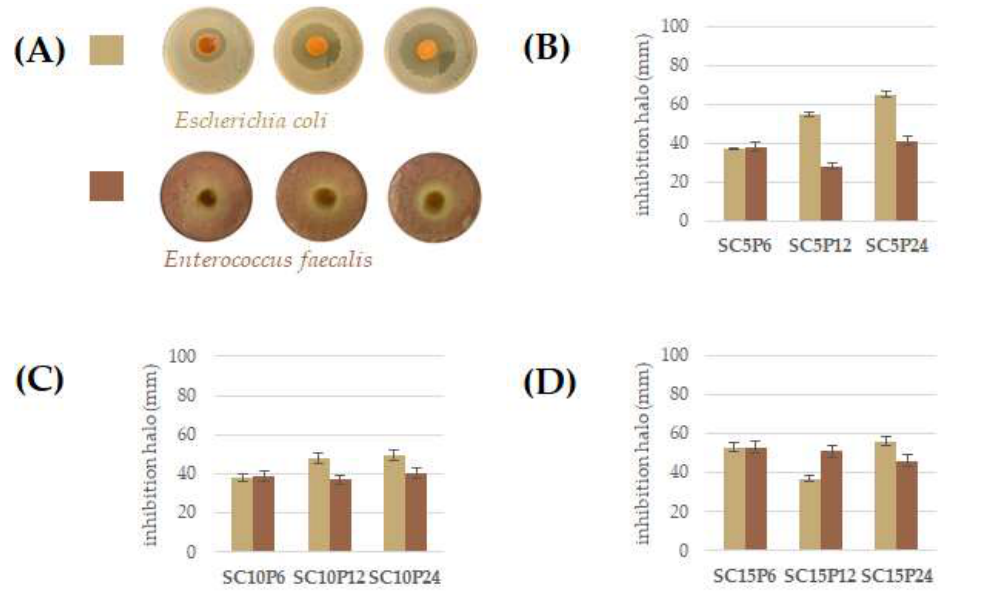
Figure 5. ( A ) Representative images of detected zone of inhibition around bacterial colonies of ( ● ) Escherichia coli , and ( ● ) Enterococcus faecalis . Inhibition halo (mm) of Escherichia coli and Enterococcus faecalis with SCP hybrids at chlorogenic acid percentage equal to 5wt% ( B ), 10 wt% ( C ), and 15 wt% ( D) . Values are calculated as mean ± SD of three independent measurements.